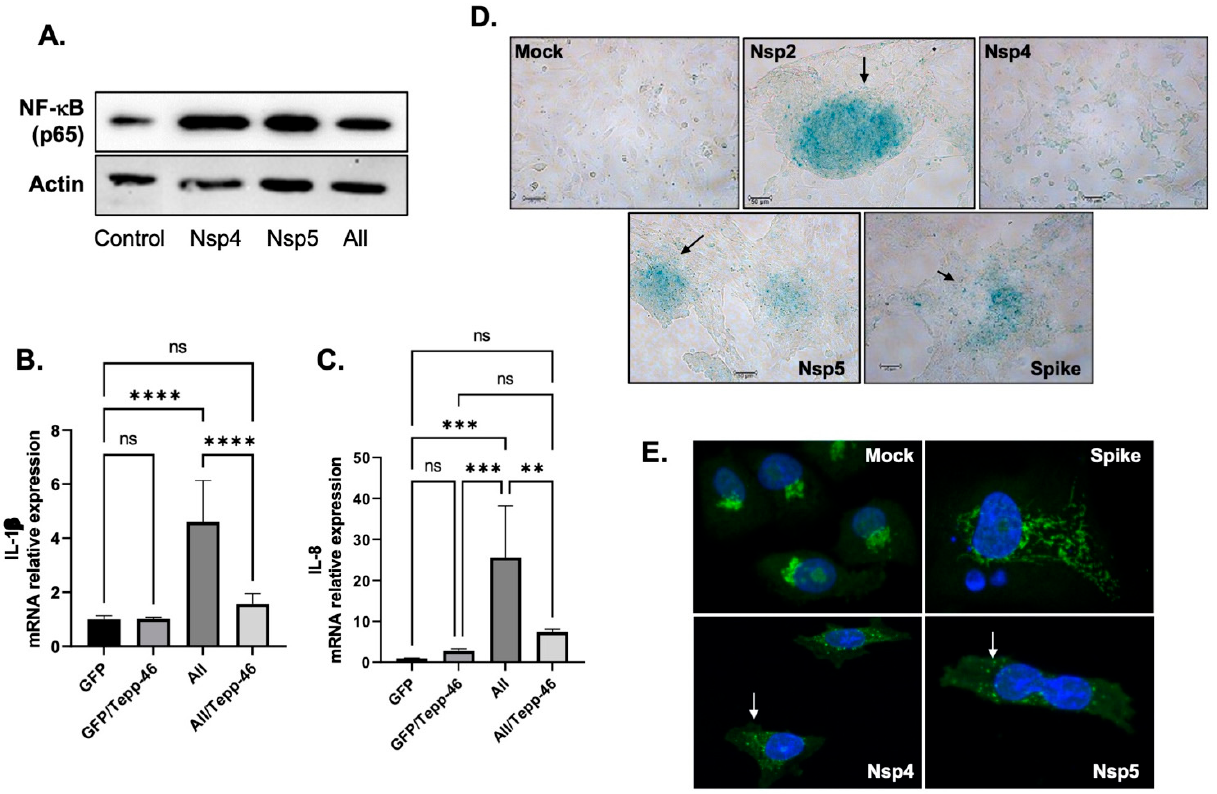
Figure 5. Persistence of Inflammation. ( A ). Expression of p65 subunit of NF-kB proteins isolated from untreated or BEAS-2B transfected as indicated by Western blot analysis. ( B , C ). mRNA expression of IL-1 β and IL-8 as obtained by qPCR using BEAS-2B transfected then treated with 10 nM of Tepp-46 as indicated. Results were judged statistically significant by ANOVA (ns = not significant; ** p < 0.01; *** p < 0.001; **** p < 0.0001). ( D ), Nsp2, Nsp4 (modest), Nsp5, and the Spike proteins promote senescence in BEAS-2B as obtained using β -gal assay compared to the Mock untransfected control. ( E ). The addition of Nsp4 and NNsp5 to BEAS-2B causes a strong Golgi apparatus fragmentation compared to the Mock or the spike alone.